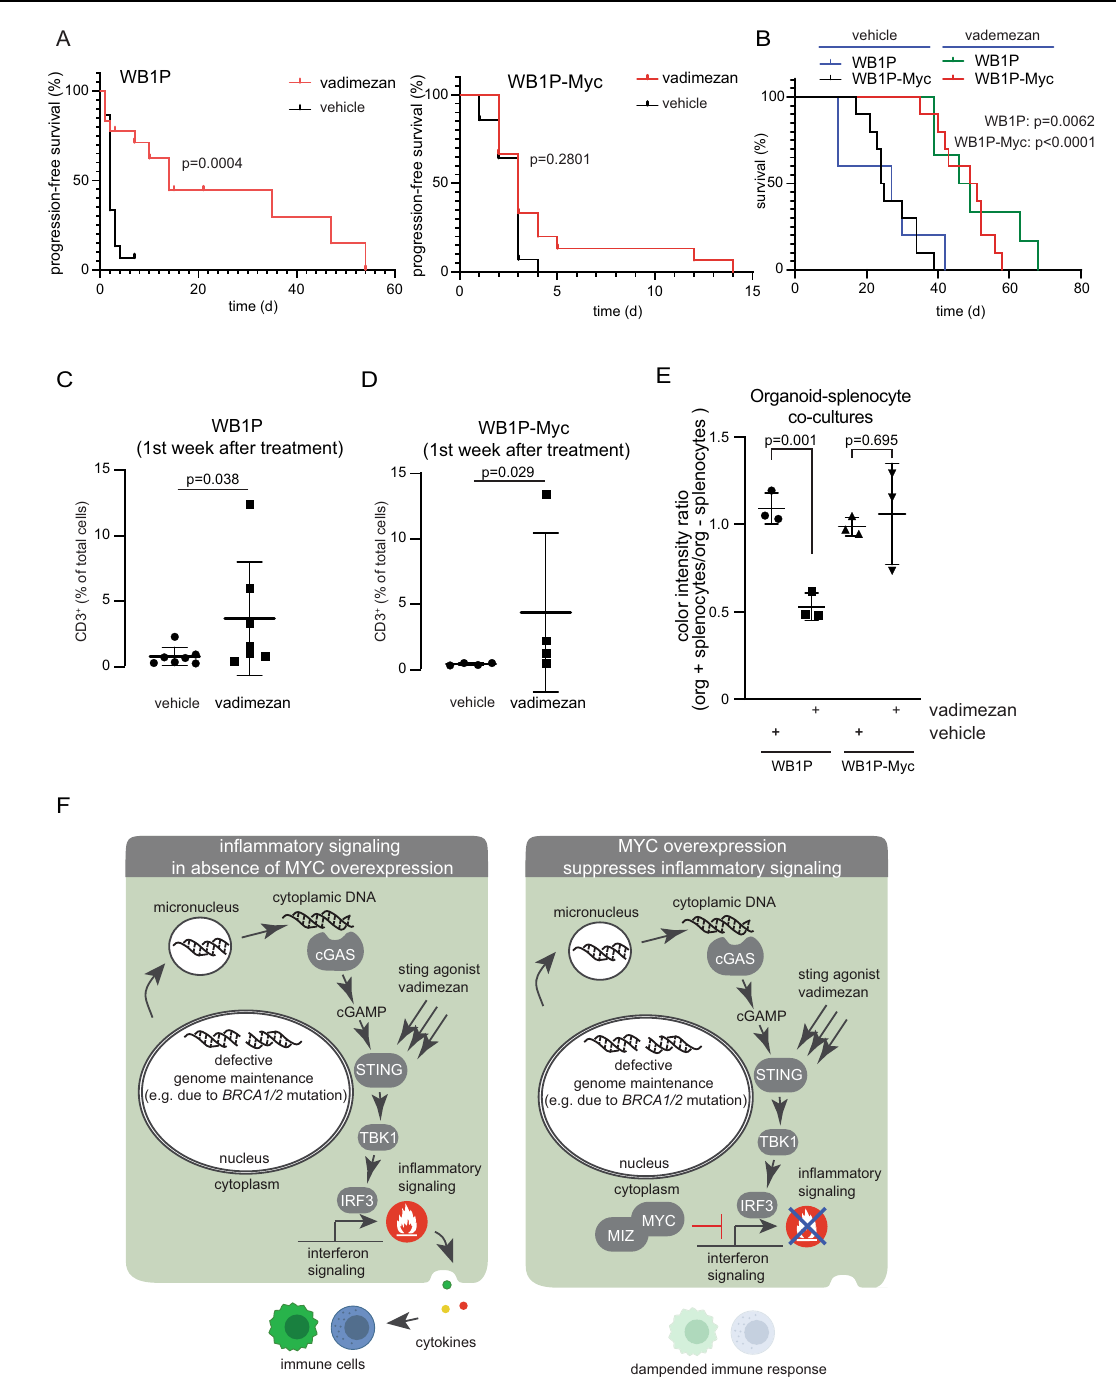
Fig. 6 | MYC suppresses anti-cancer ef fi cacy of pharmacological STING activa- tion in WB1P tumors. A Kaplan-Meyer-curves of mice carrying WB1P tumors (left panel) or mice carrying WB1P-Myc tumors (right panel) and treated every 14 days for6weekswithvehicleor25mg/kgvadimezani.pwhentumorsreached100mm 3 . Shown is the time of progression-free survival after treatment ( n =10, Log-rank (Mantel-Cox)test). B Kaplan-Meyer-curvesofmicecarryingWB1P tumorsorWB1P- Myc tumors, treated as for A . Shown is the time of overall survival after treatment ( n =10, Log-rank (Mantel-Cox) test, p =0.0062 for WB1P and p<0.0001 for WB1P- Myc). C AnalysisofCD3+cellcountsinvehicleandvadimezantreatedWB1Ptumors inthe fi rstweekaftertreatment.PlottedarepercentagesofCD3+cells/totalcellsas analyzed by quPath ( n =7, unpaired two tailed Mann-Whitney test, p <0.05, mean with SD plotted). D Analysis of CD3+ cell counts in vehicle and vadimezan treated WB1P-Myc tumors in the fi rst week after treatment. Plotted are percentages of CD3+ cells/total cells as analyzed by quPath. ( n =4, unpaired two tailed Mann-